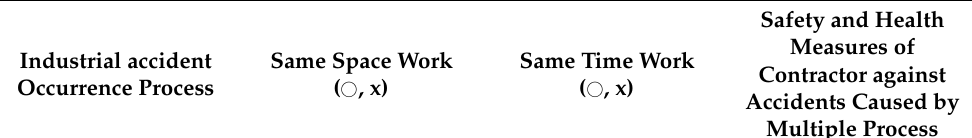
Table 11. Cases of collapse accidents by multiple processes in the workplace.